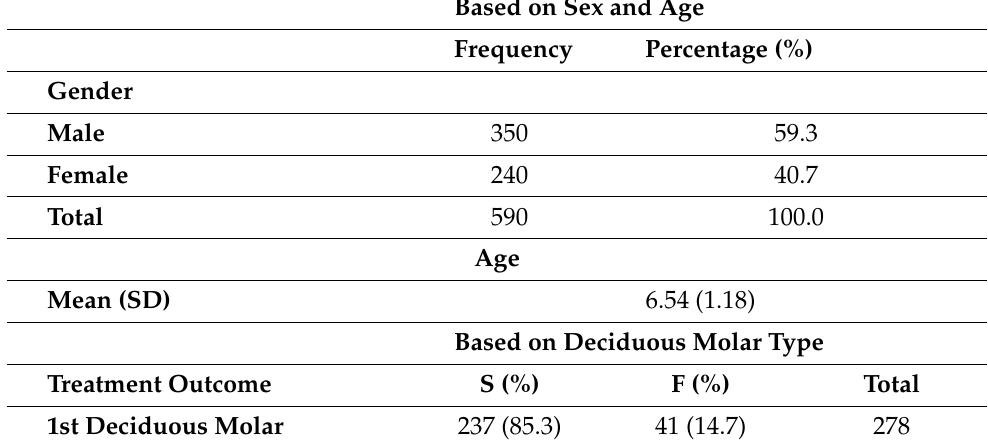
Table 1. Distribution of different variables based on the type of VPT performed.